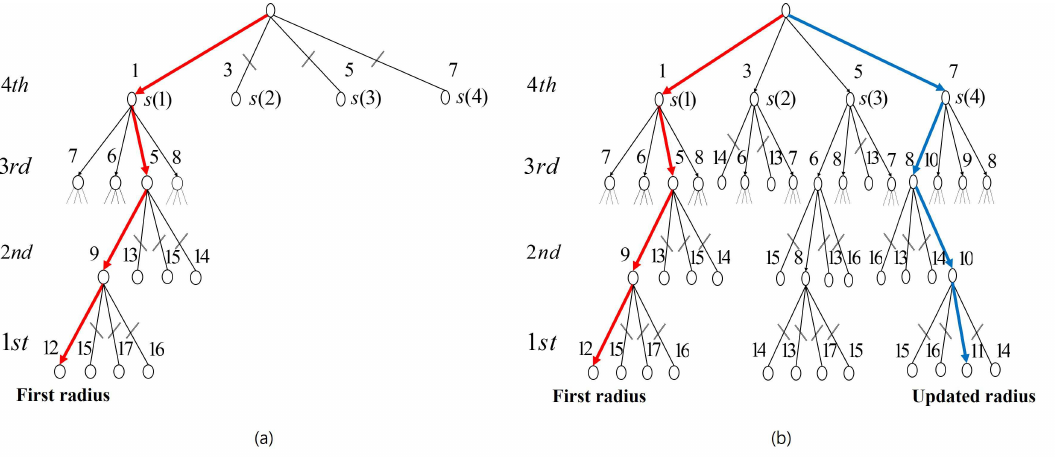
Figure 3. Adaptive DFSD tree structure in 4 × 4 MIMO-OFDM system with QPSK modulation. ( a ) Proposed detection scheme in the best channel condition; ( b ) Proposed detection scheme in the worst channel